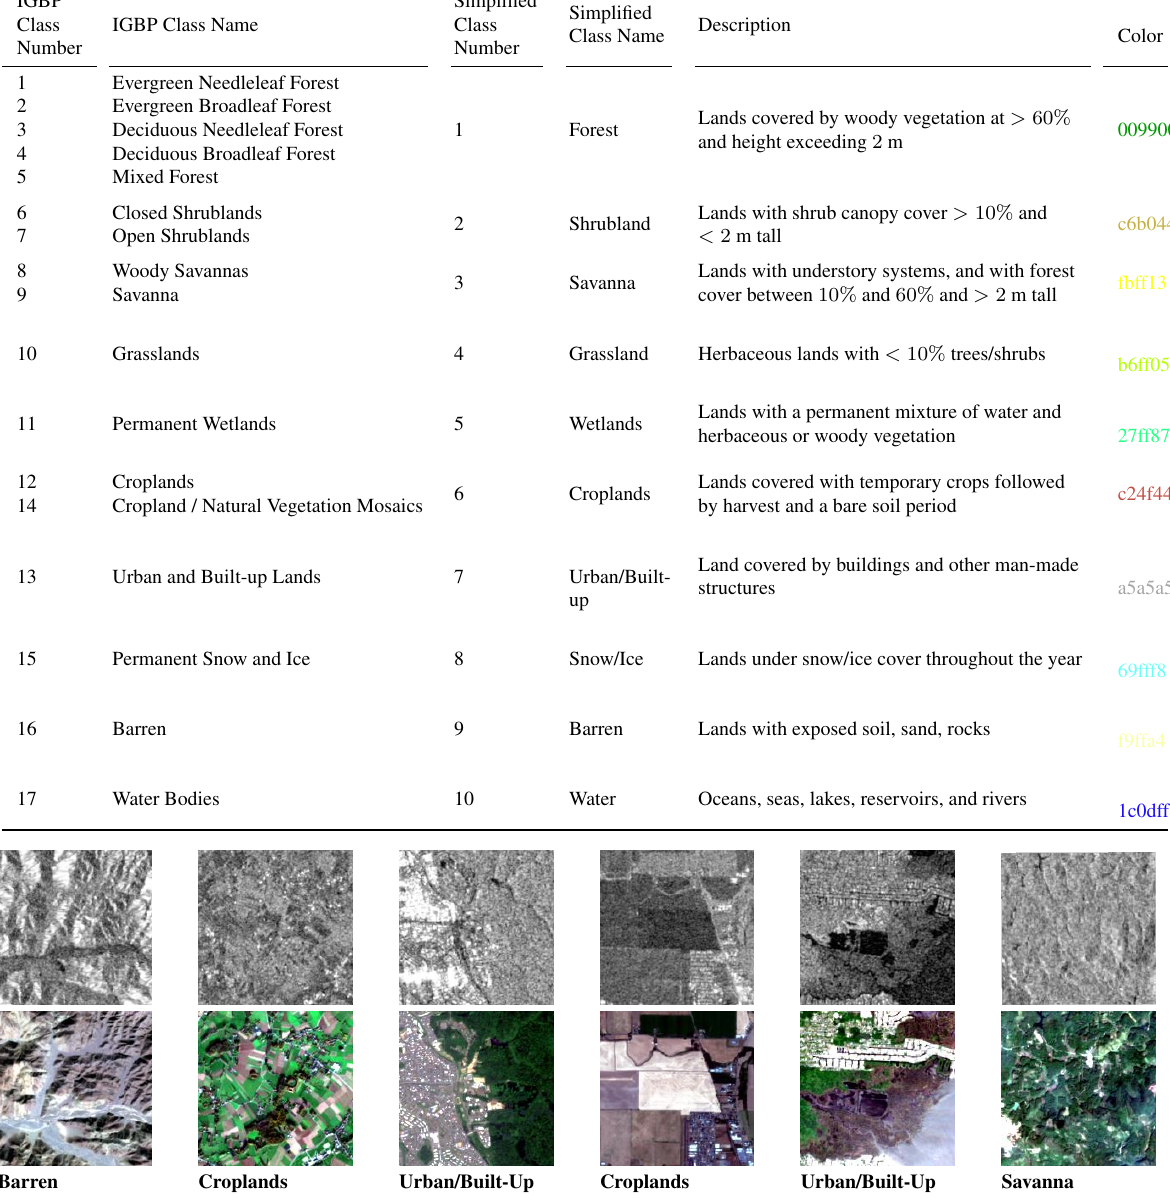
Table 2: The simplified IGBP land cover classification scheme.